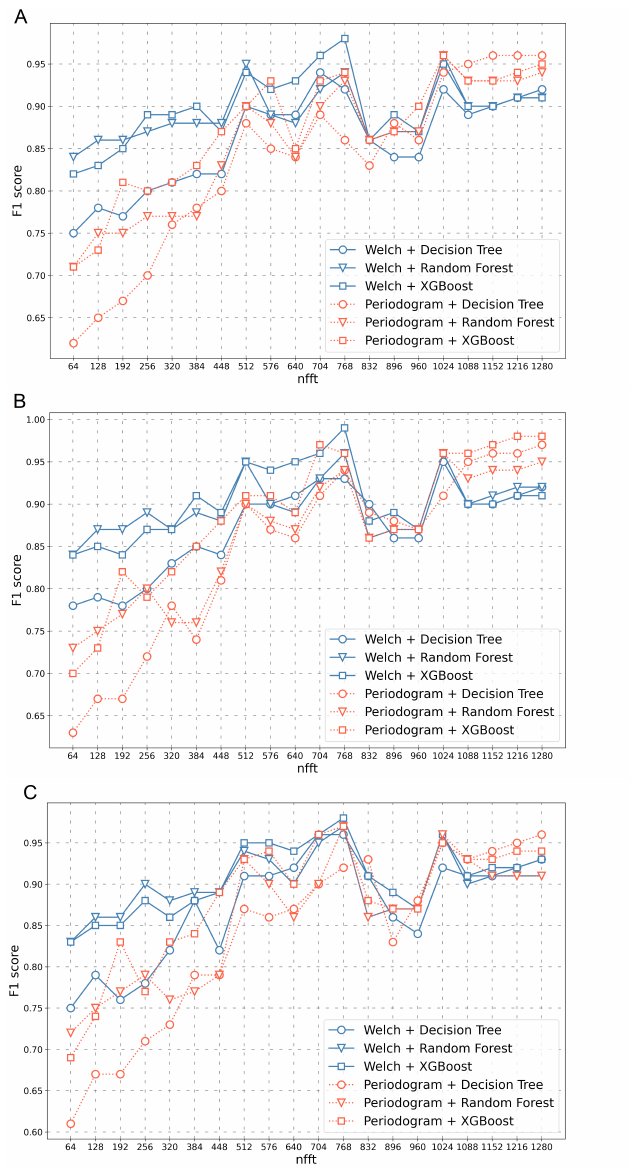
Figure 4. The value of the F1 score parameter depending on the nf ft value for various transformation methods and classifiers as well as three channels analysed separately (Red—( A ), Green—( B ), Blue—( C